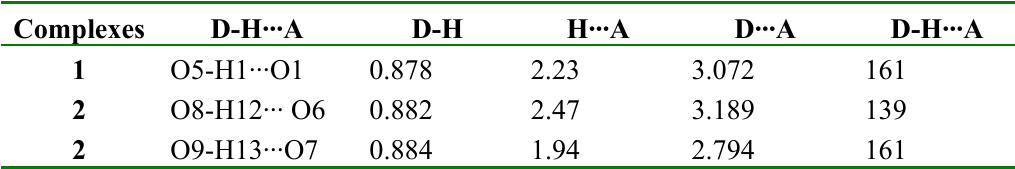
Table 3. Hydrogen-bonding geometry (Å) for complexes 1 and